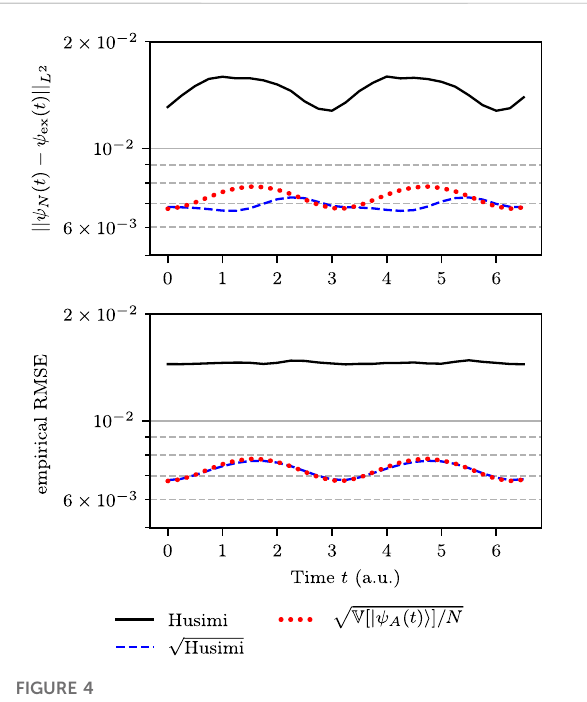
Figure 4. For K → ∞ , due to the strong law of large numbers, S K